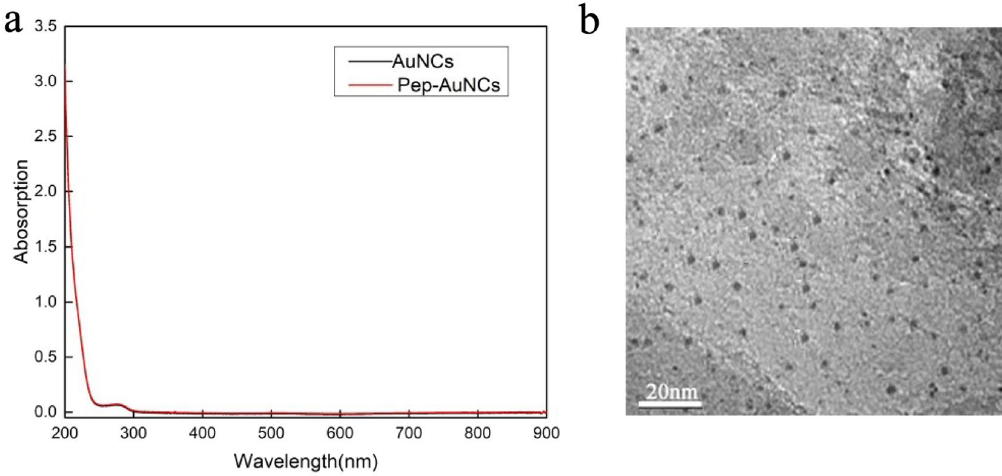
Figure 2. Characterization of the CCYWDAHRDY-AuNCs: ( a ) TEM photograph of the CCYWDAHRDY- AuNCs, ( b ) UV–visible absorption spectrum of the AuNCsand the CCYWDAHRDY-AuNCs.